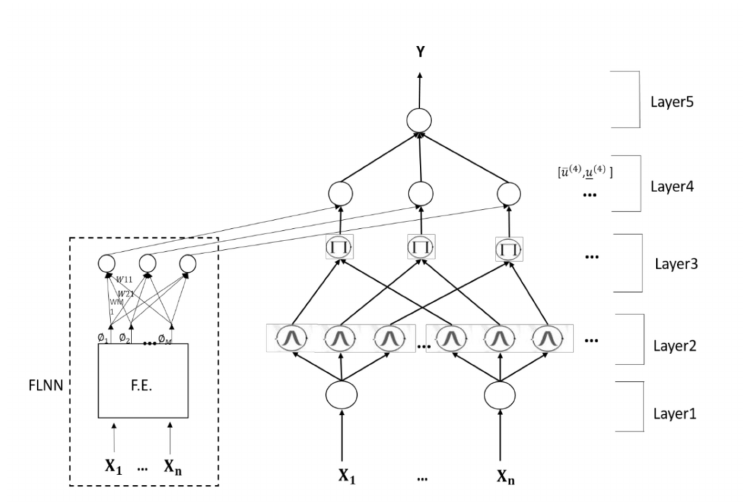
Figure 1. Structure of an interval type-2 fuzzy neural network